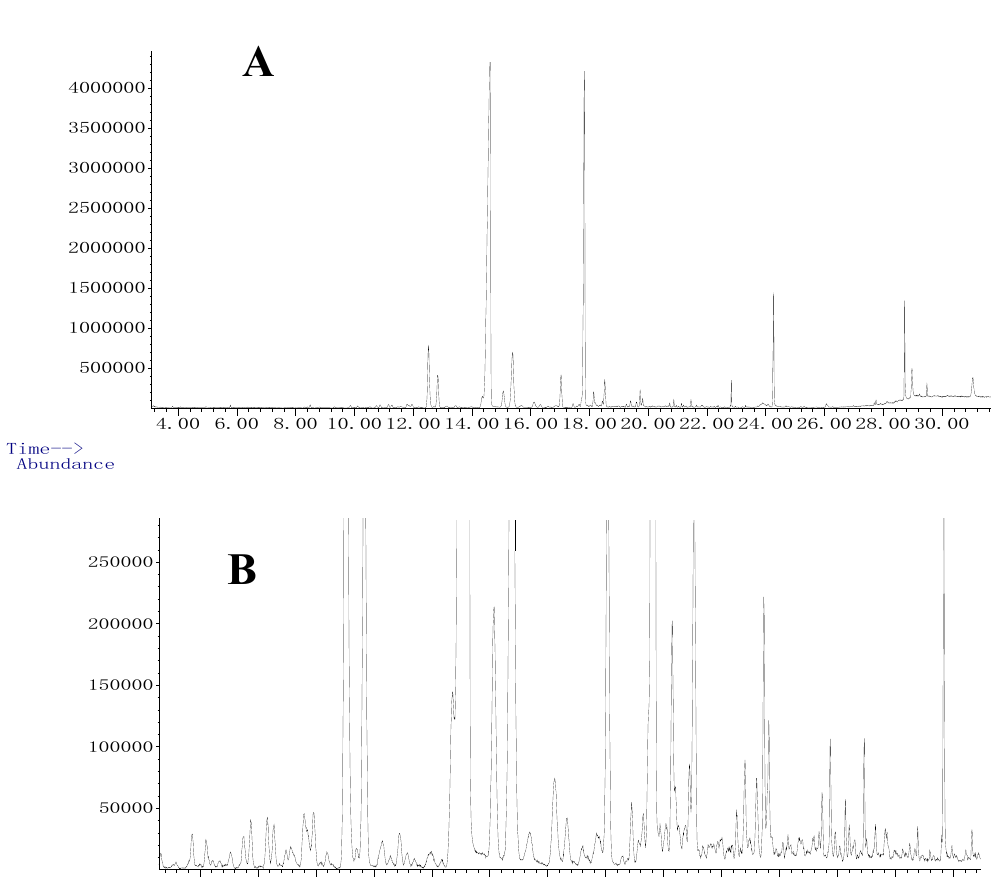
Figure 3. The total ion current profiles of essential oil from O. horridus ; original profile ( A ) and enlarged profile from 9 to 25 min ( B